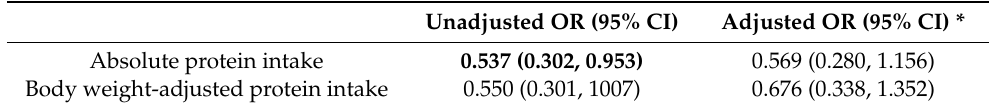
Table 5. Binary regression for protein intake and